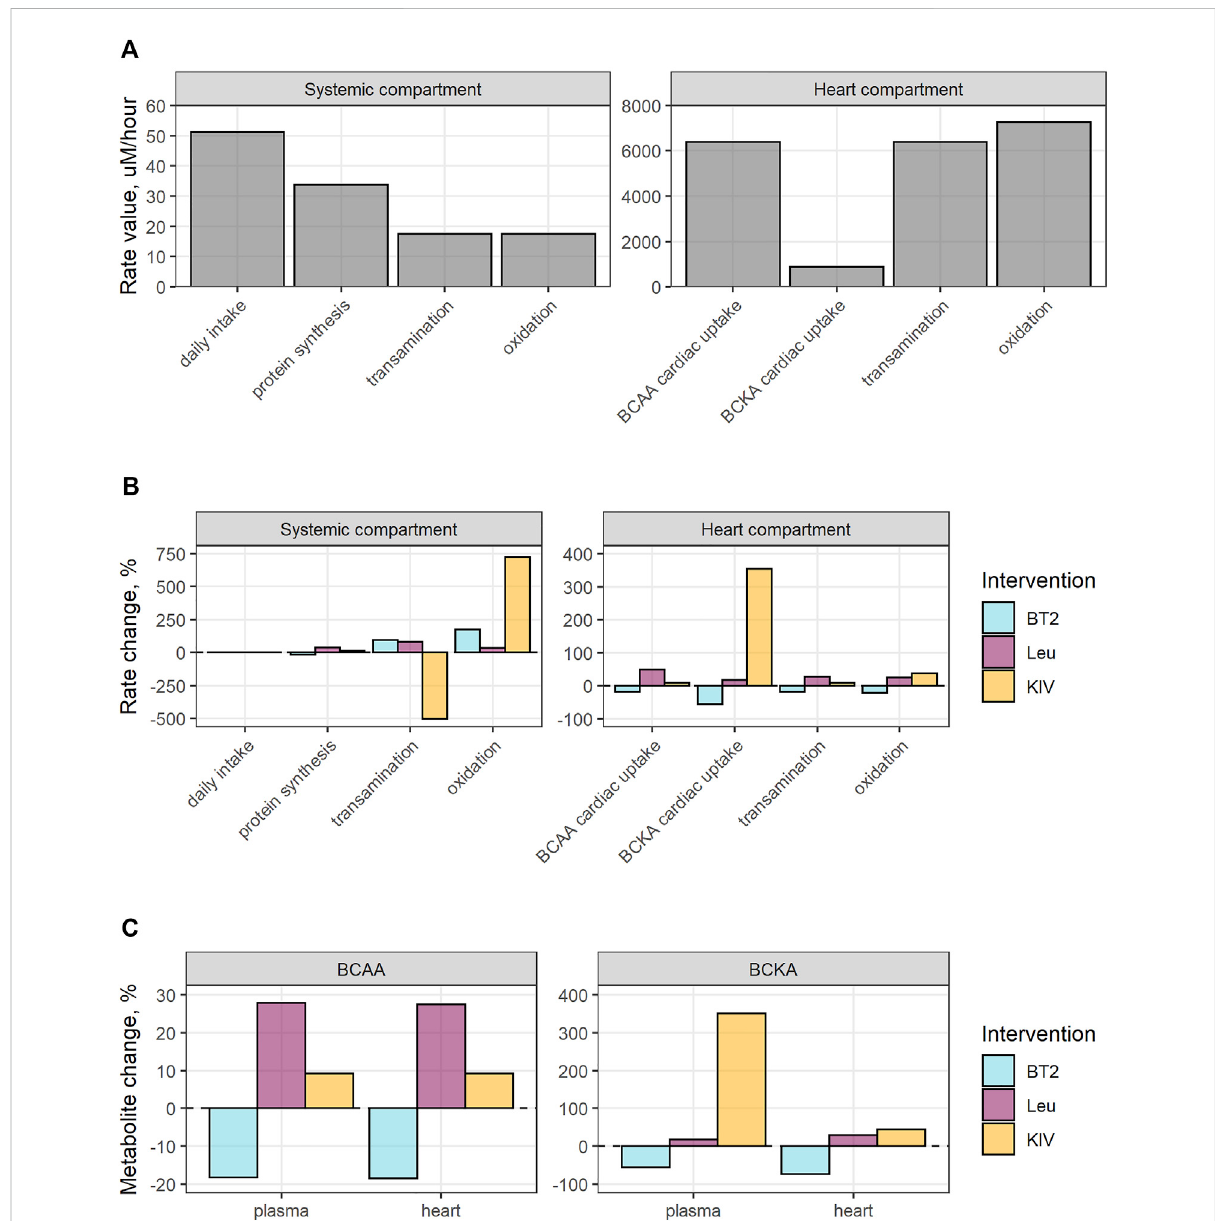
FIGURE 4 Analysis oftheimpactofBT2,BCAAorBCKAintakeonthehomeostaticsystem. (A) Pre-treatment reactionrates; (B) The effectofinterventions on the reaction rates; (C) Changes in metabolite levels under the treatment. Simulation design implied single administration of 40 mg/kg BT2, 100 umol Leu, or 100 umol KIV; maximal impact of the treatment on biomarkers is